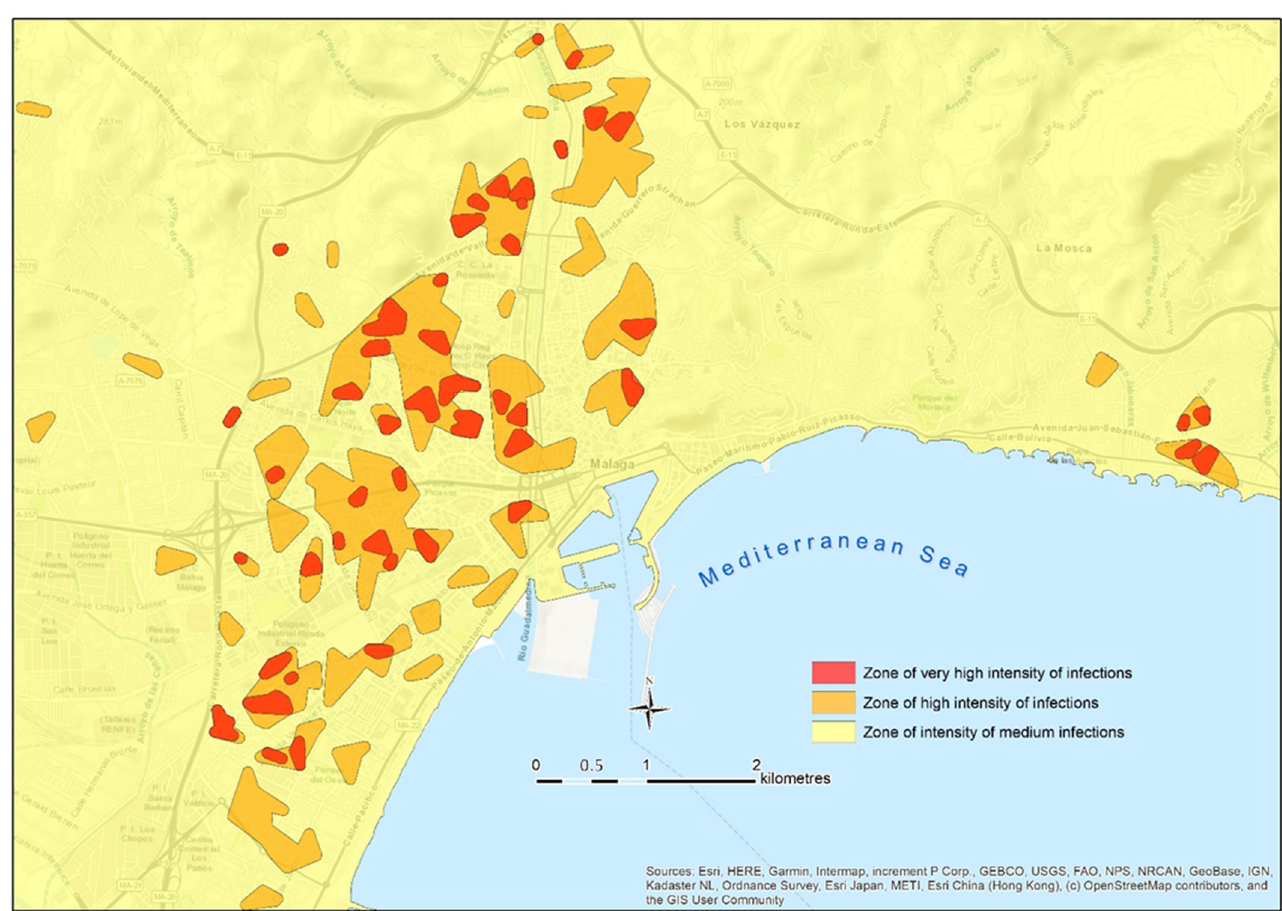
Figure 11. Gradation of the intensity of the contagion from the delimitation of the focuses and micro-focuses.